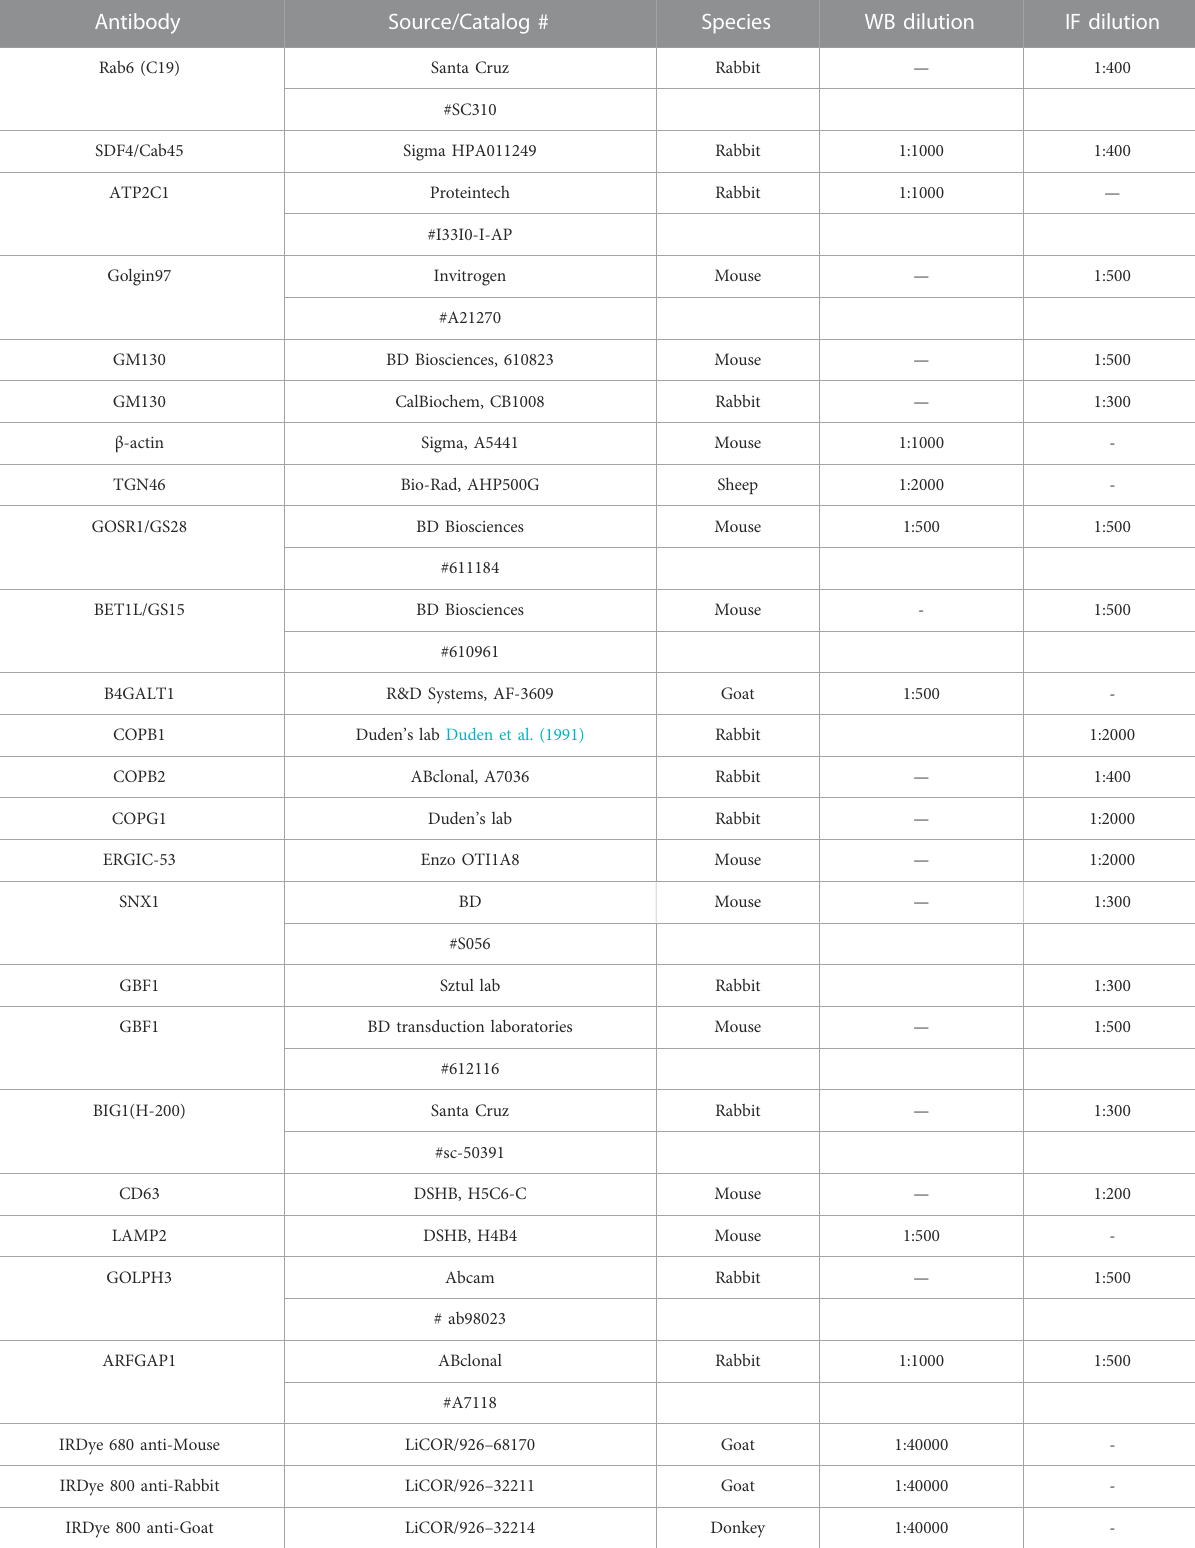
TABLE 1 List of Antibodies used in the